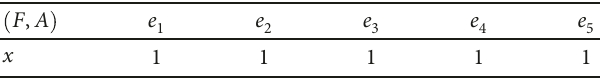
Table 7: Fuzzy soft set F